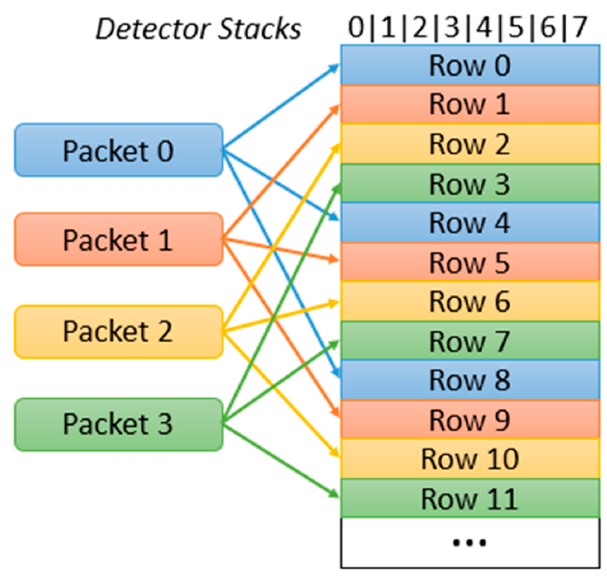
Figure 7. Graphic representation of the Level 0 data structure for ABI.